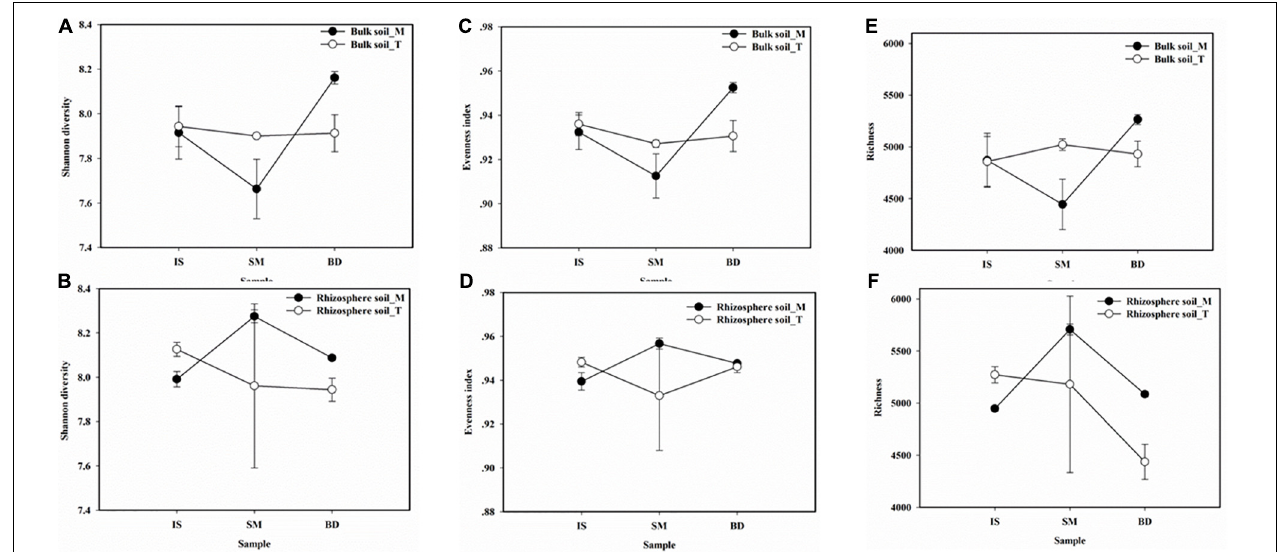
FIGURE 3 | Prokaryotic community α -diversity succession along the chronosequence. (A) and (B) were Shannon diversity in bulk and rhizoshpher soils, respectively. (C) and (D) were the Evenness index in bulk and rhizoshpher soils, respectively. (E) and (F) were the Richness in bulk and rhizoshpher soils, respectively. Data were shown as average ± se ( n = 3). Sites: IS, middle of glacier terminal and small Qiangyong lake; SM, midway along the edge of the smaller lake; BD approximately one-third of the way along the edge of the larger lake. M and T indicate the sampling lines, Middle and Top,